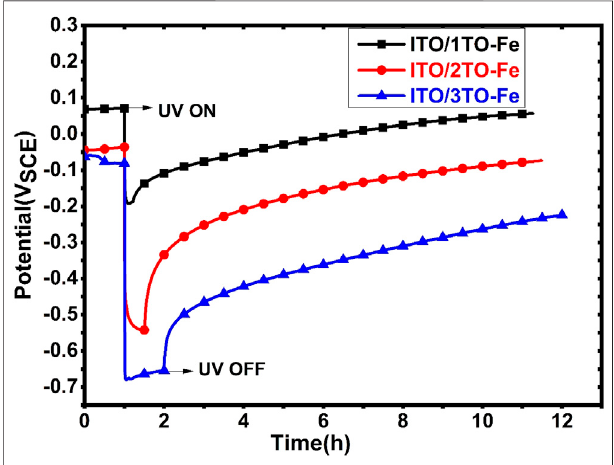
FIGURE9| OCP responses ofITO/1TO-Fe, ITO/2TO-Fe, and ITO/3TO- Fe in the designated electrolyte solutions to the absence and presence of UV